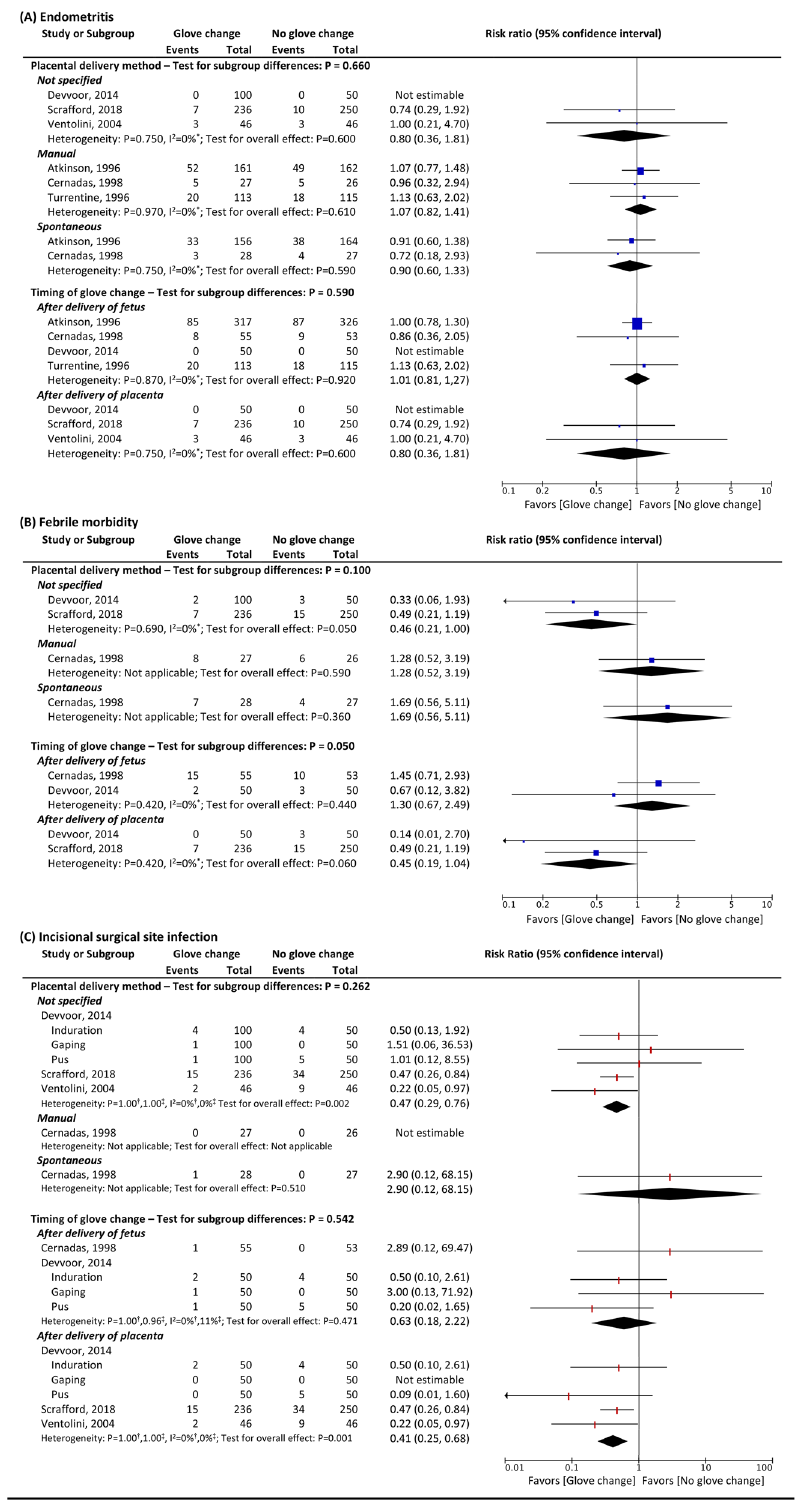
Figure 4. Subgroup analyses of the effects of intervention by placental delivery method and timing of glove change. Manual = manual placental removal, Spontaneous = spontaneous placental delivery, * heterogeneity of two-level meta-analysis explained by I 2 , † heterogeneity of three-level meta-analysis explained by variance within 2 ) , ‡ heterogeneity of three-level meta-analysis explained by variance between the studies (σ 2 the study (σ 2